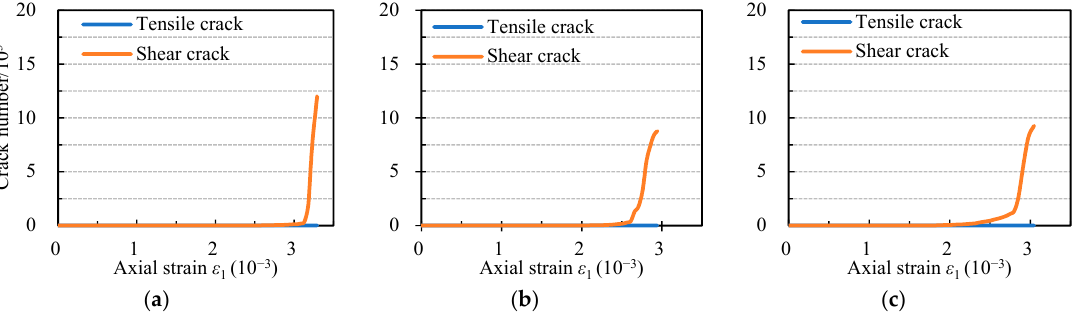
Figure 13. Intact material crack number evolution of transversely isotropic jointed rock models having dip angles of ( a ) α = 45°, ( b ) α = 60° and ( c ) α = 75°.